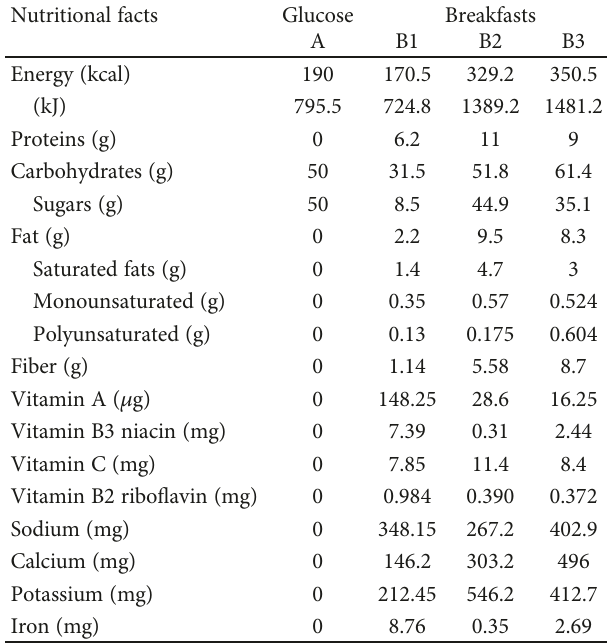
Table 1: Anthropometrical and clinical characteristics of the study subjects.